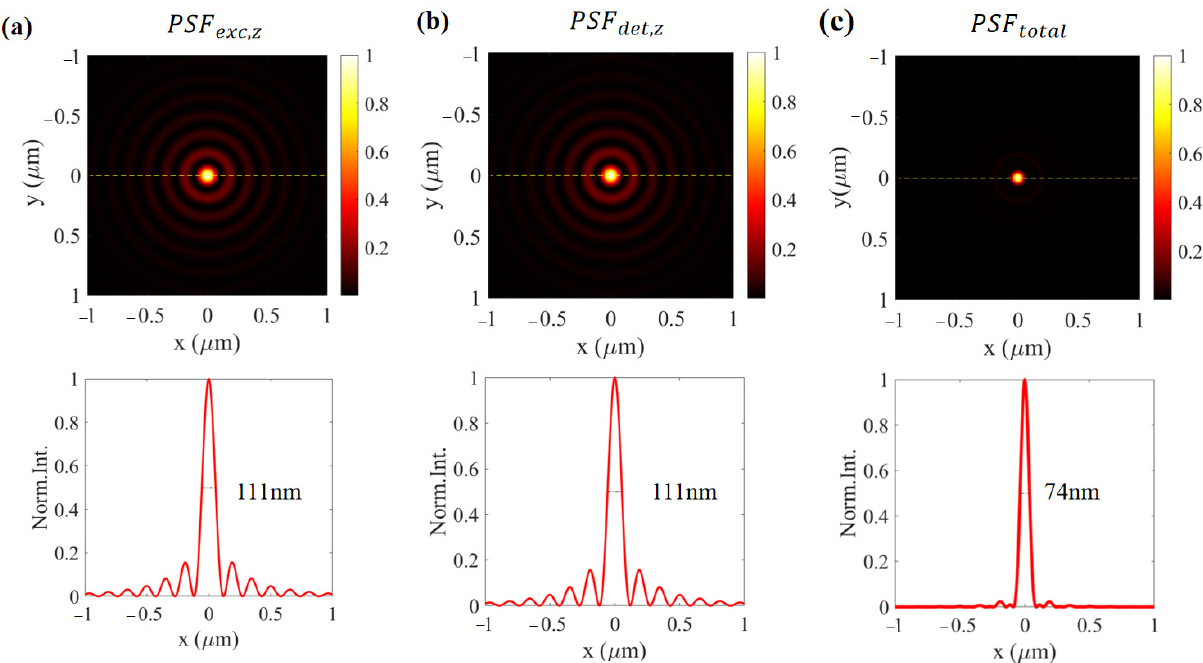
Figure 2. ( a ) The longitudinal component of PSF for excitation system, ( b ) the intensity of the detection PSF, and ( c ) the total PSF for the whole CLSM. The magnification of the objective in the CLSM is set as 100X.